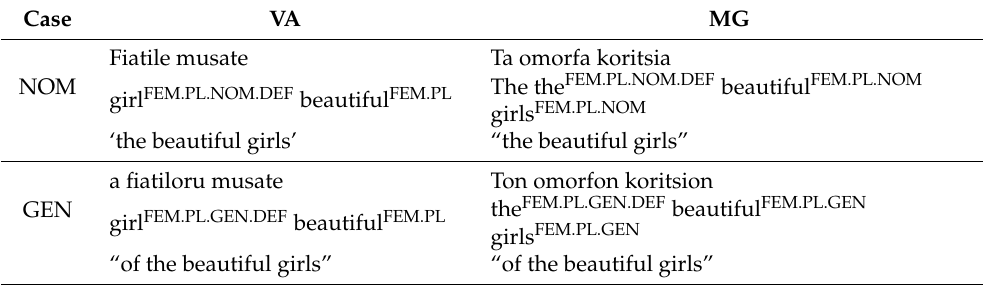
Table 2. Adjective position in VA and